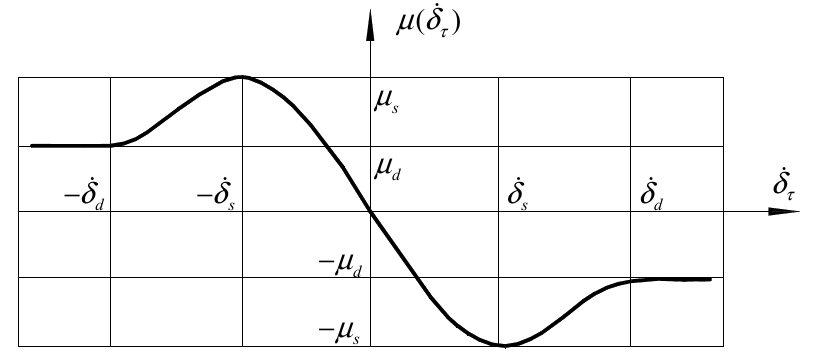
Figure 6. Relation diagram of relative sliding velocity and friction coefficients.